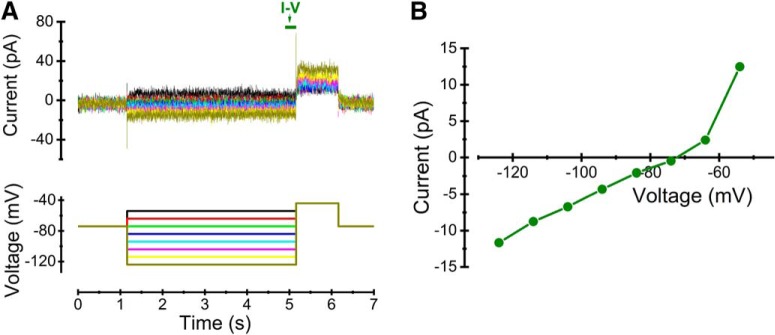
Lack of ClC-2 currents. A, Voltage protocol (bottom) used for detecting ClC-2 currents and corresponding currents (top) recorded in an MPN neuron. Colors of individual current traces matches the colors in the voltage protocol. B, I-V relation for the currents in A (average amplitude during the time marked by olive bar in A). Note the small amplitude and the linearity in the range below –65 mV.